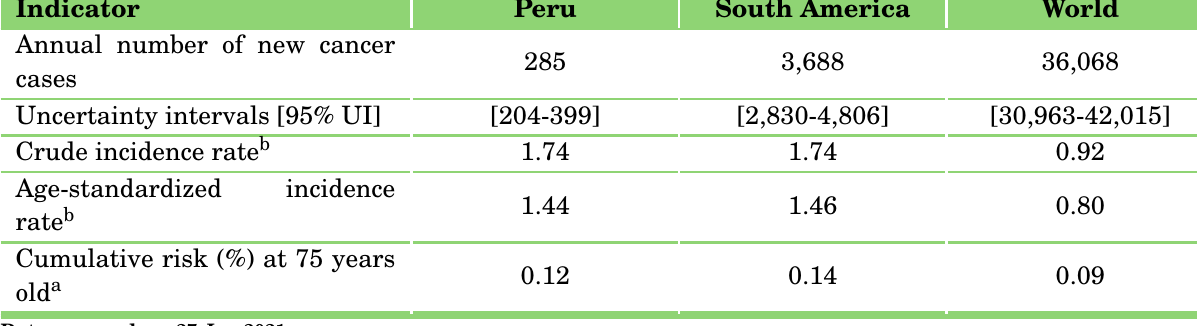
Table 13: Penile cancer incidence in Peru (estimates for 2020) Indicator Peru